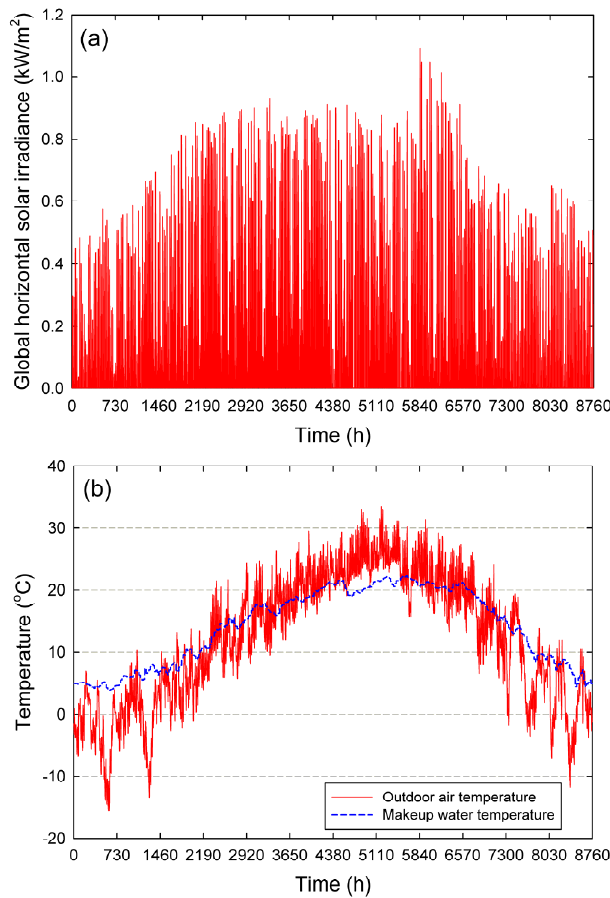
Figure 4. ( a ) Hourly global horizontal solar irradiance and ( b ) outdoor air temperature and makeup water temperature over one year in Incheon, South Korea.